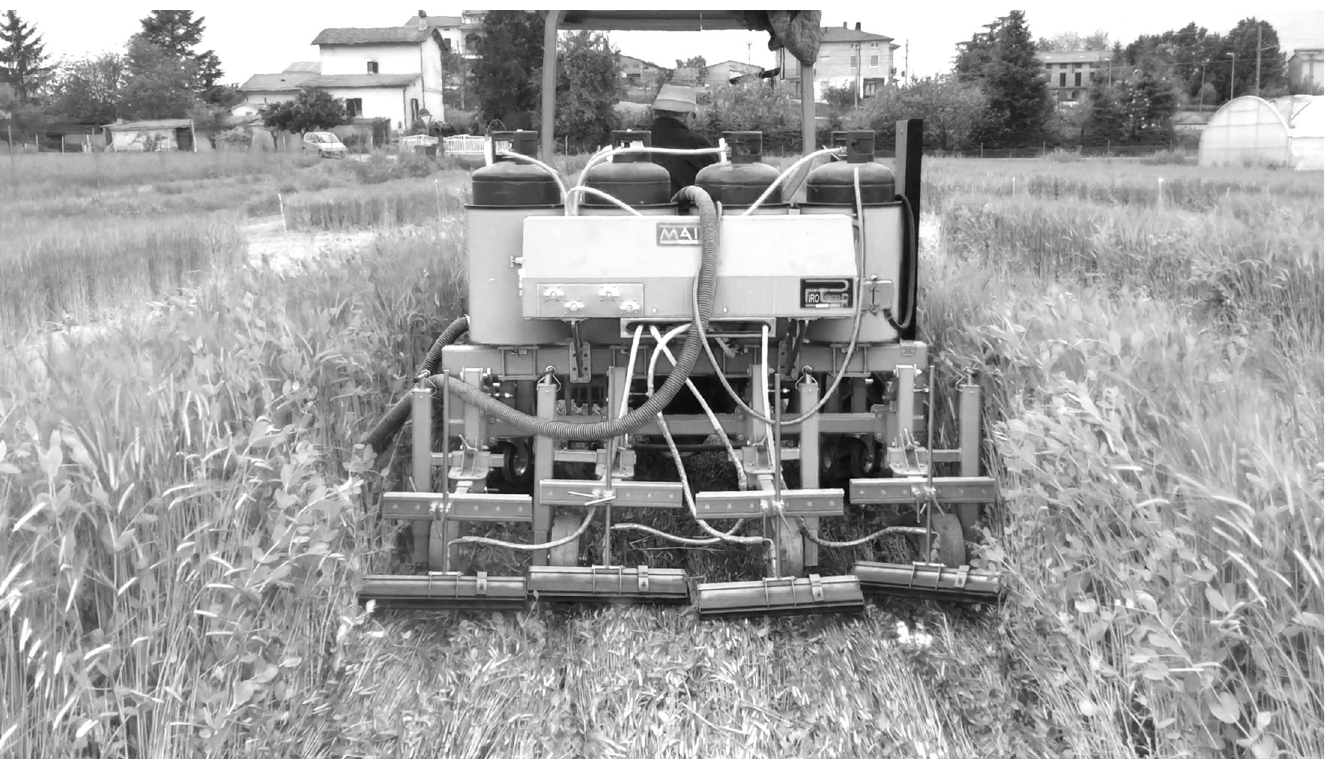
Fig 6. The flaming machine conducting cover crop mixture termination after the roller crimper operation.